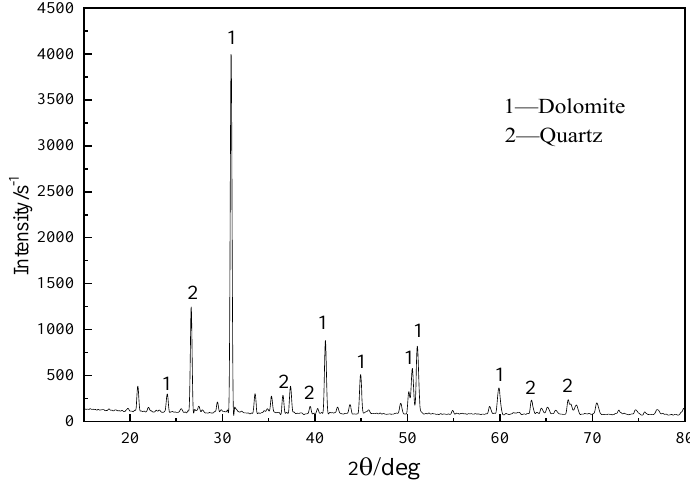
Figure 1. XRD analysis of materials. Table 1. Results of copper phase analysis.